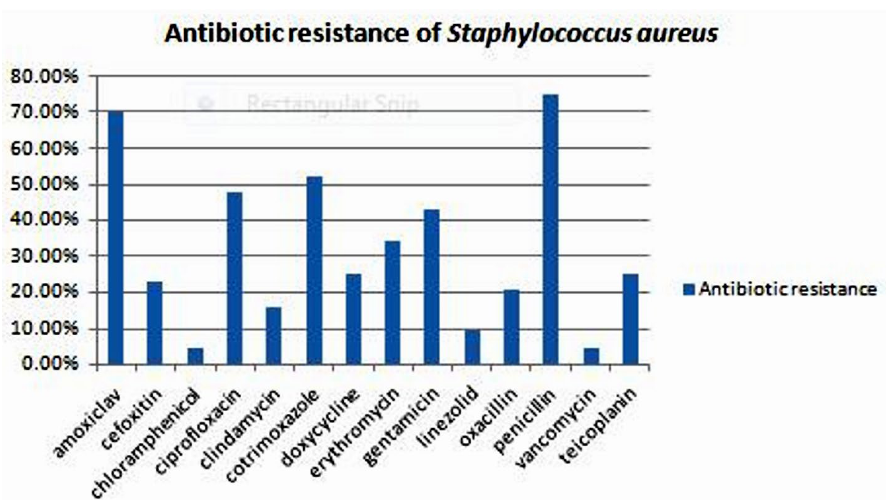
Fig. 5. Antibiotic resistance of Staphylococcus aureus isolated in this